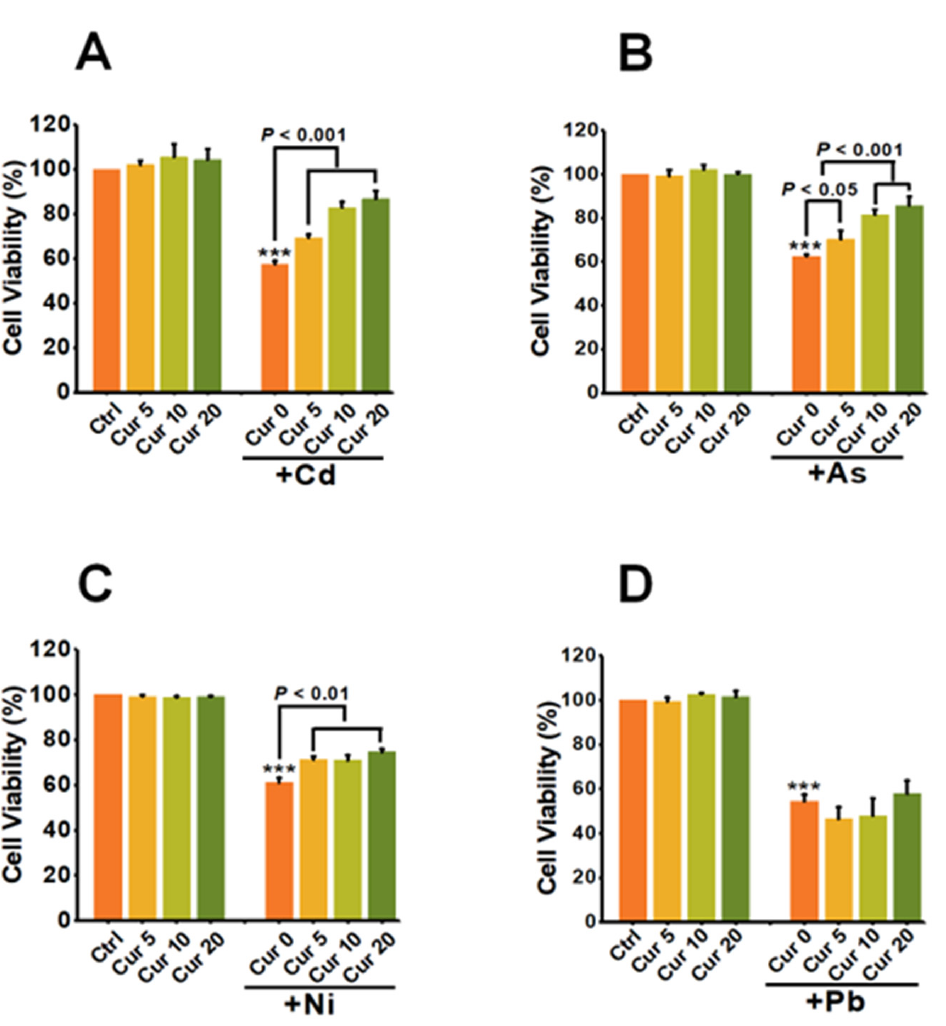
Figure 2. The effects of curcumin on the cytotoxicity of heavy metals ( n = 3). HepG2 cells were pre-treated with curcumin for 8 h, followed by ( A ) Cd, ( B ) As, ( C ) Ni and ( D ) Pb treatment for another 24 h. The concentrations of curcumin were 5, 10 and 20 µ M, respectively. The concentrations of heavy metals were 6 µ M for Cd, 100 µ M for As, 2 mM for Ni and 2.5 mM for Pb, respectively. *** p < 0.001, compared to the untreated group. Figure 3 indicates the co-effects of curcumin and various heavy metals on apoptosis. The value of 20 µ M curcumin used in this study had little effect on inducing apoptosis; in contrast, a significant elevation in apoptotic rates could be detected in Cd-, As- and Ni-treated HepG2 cells. Pre-treatment with curcumin for 8 h sharply relieved the apoptosis elicited by Cd, As and Ni, which itself had little impact on apoptosis induction. The apoptotic rates declined from 44.1% to 6.7%, 33.2% to 9.7%, and 30.6% to 19.4% for Cd, As and Ni, respectively metals. Similar to the observation of the cellular viability assay, scarcely any amelioration could be detected in Pb-exposed cells after curcumin pretreatment (Figure